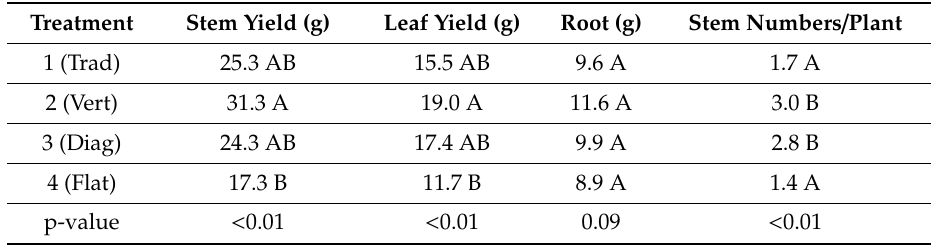
Table 4. Glasshouse planting orientation trial 2014. Stem yield represents above ground dry matter biomass measured in weight per total stems per pot, leaf yield is the dry matter weight of the leaves, root yield represents the average dry matter yield per pot and the stem numbers the average stems present per pot.